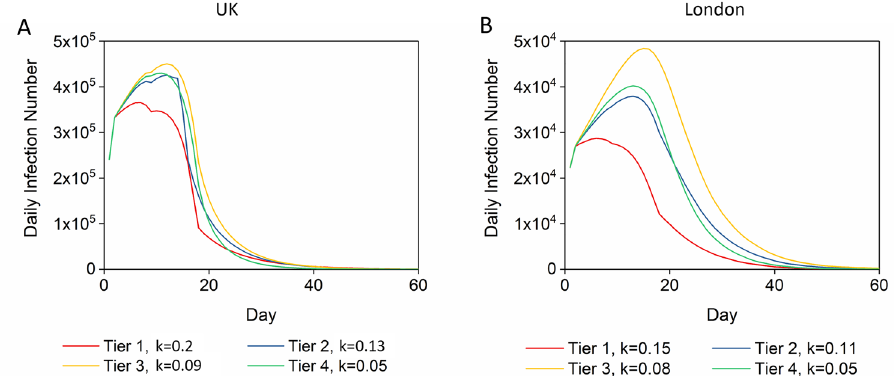
Figure 5. The daily infection curves at the recovery stage with proper control strategies. ( A , B ) Ideal daily infection curves starting with a daily infection number of 220,000 in the UK/22,000 in